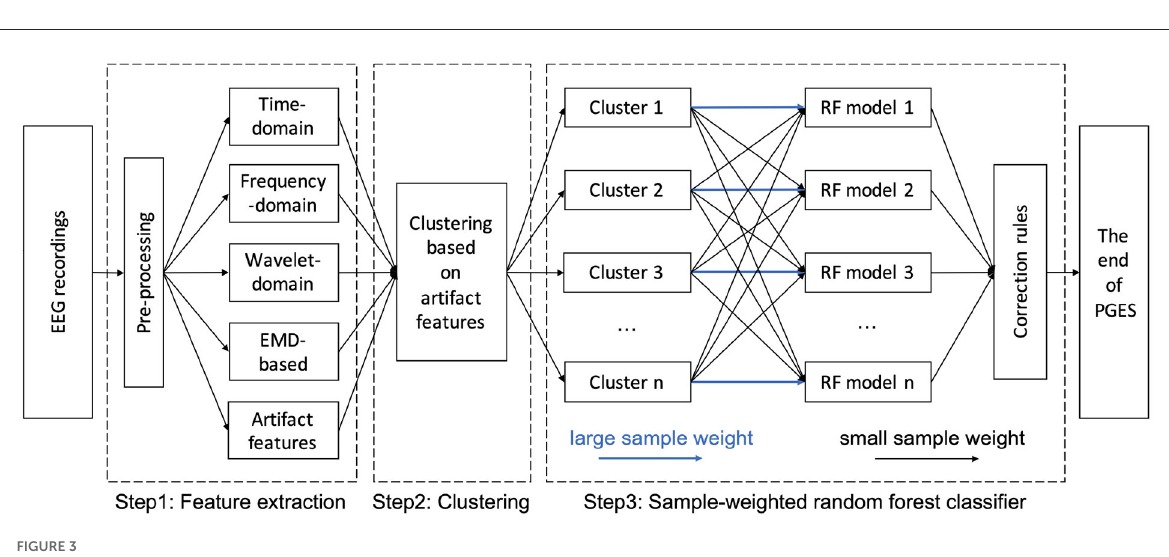
FIGURE3 A hybrid architecture for PGES